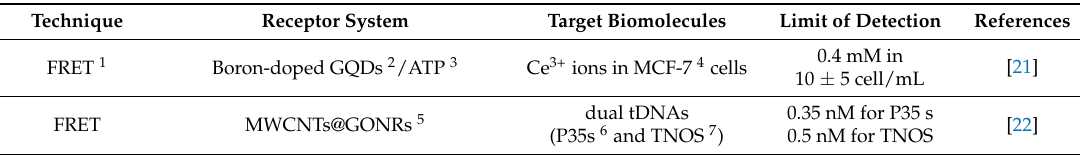
Table 1. Current generation reports of graphene-based biosensors.